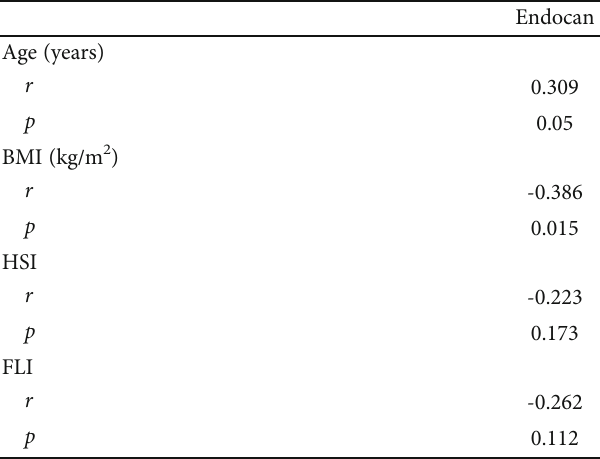
Table 2: Correlation between endocan and characteristics in patients of